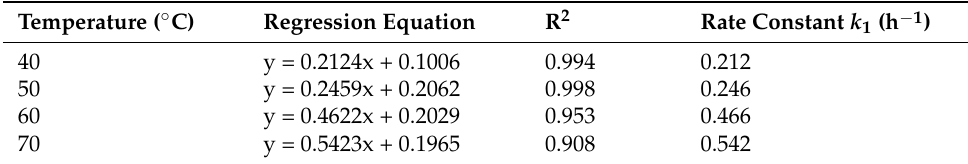
Table 5. Effect of the temperature vs.